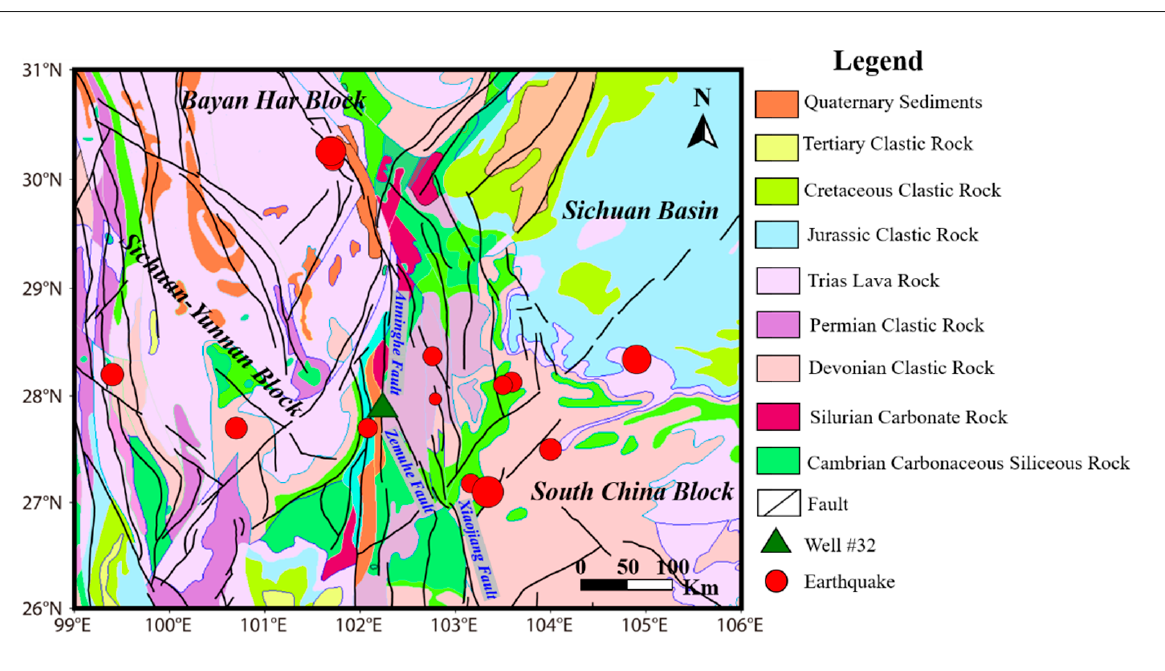
Figure 1. The location and geological setting of well #32.